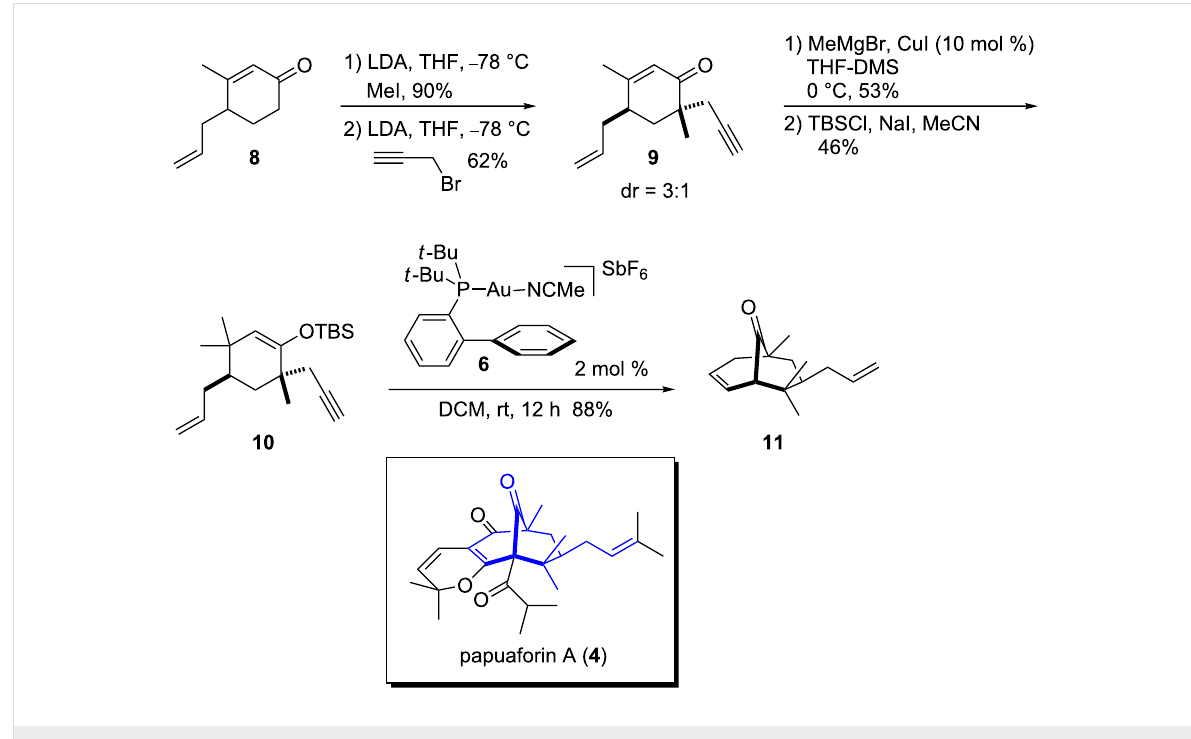
Scheme 2: Synthesis of papuaforin A core 4 .